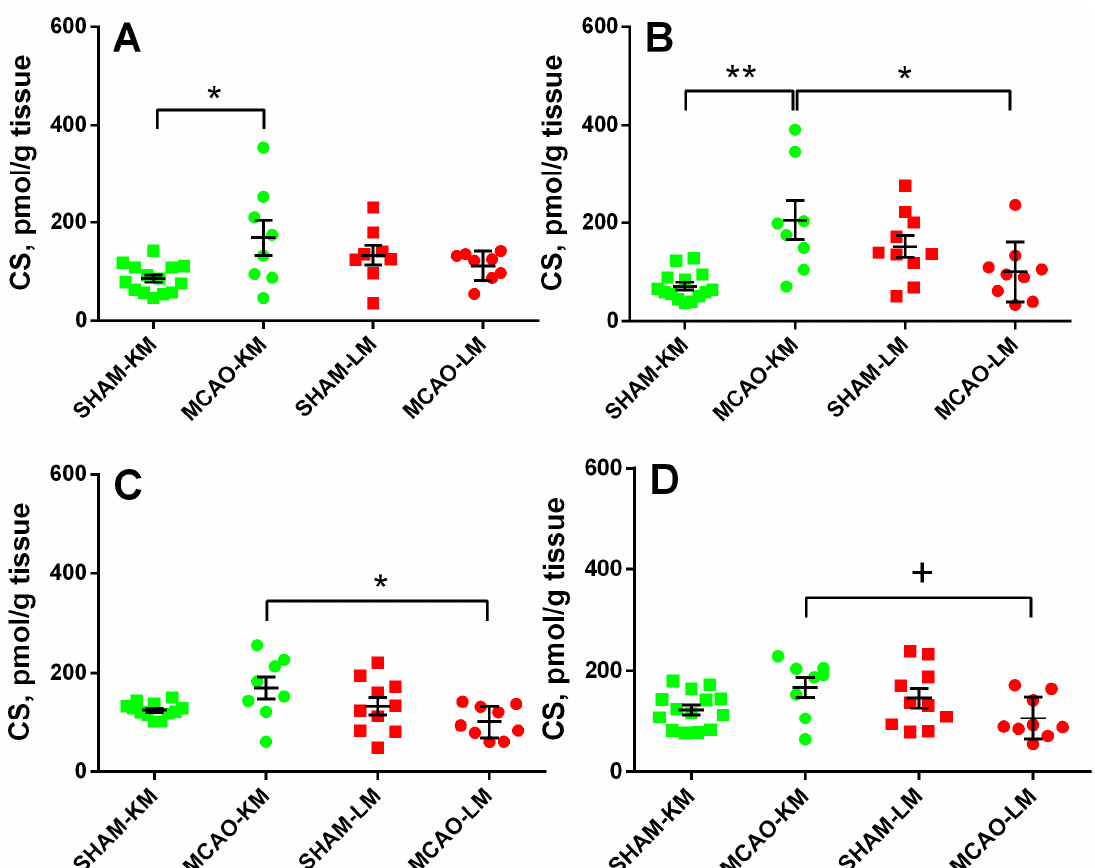
Figure 3. Corticosterone levels in the hippocampus ( A , B ) and FC ( C , D ) of MCAO-KM and MCAO-LM groups 3 months after surgery. ( A ) Ipsilateral hippocampus. ( B ) Contralateral hippocampus. ( C ) Ipsilateral FC. ( D ) Contralateral FC. ( A – D ) Corticosterone (CS), pmol/g tissue.** p < 0.01, * p < 0.05, and + p < 0.1 compared with respective sham-operated groups or MCAO-KM and MCAO-LM.